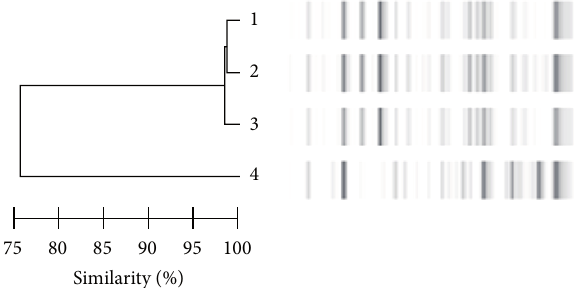
Figure 1: Rep-PCR analysis: dendrogram of similarity and molec- ular profiles of L. pneumophila serogroup 1 isolated from various specimens. (1) Isolates from home shower without flushing. (2) Isolates from home shower after flushing. (3) Clinical strain. (4) Isolates from the tank of the oncology